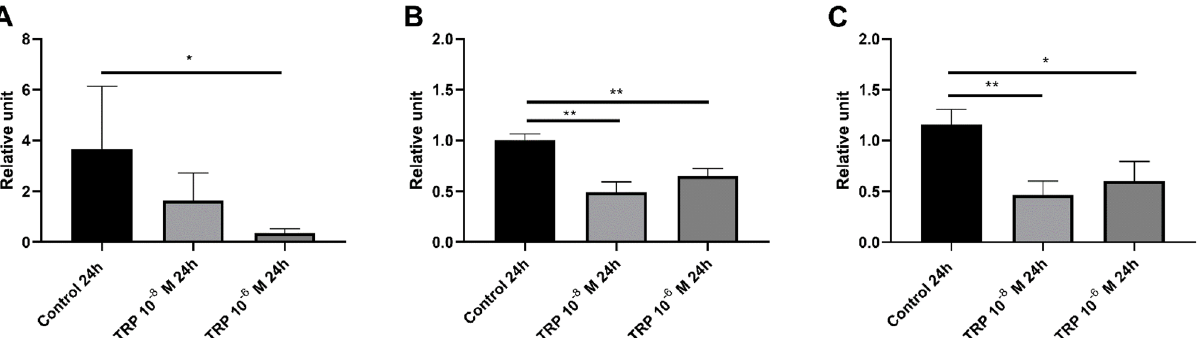
Figure 8. Reverse transcription quantitative PCR (RT-qPCR) analysis on the expression levels of genes encoding selected antimicrobial peptides (( A ) attacin 2; ( B ) tenecin 3) and the Toll receptor ( C ) in immune- related tissues (pooled fat body and haemocytes) 24 h after applying Tenmo-TRP-7 at concentrations of 10 –8 and 10 –6 M. Values are the means 土 SEM. * p ≤ 0.05; ** p ≤